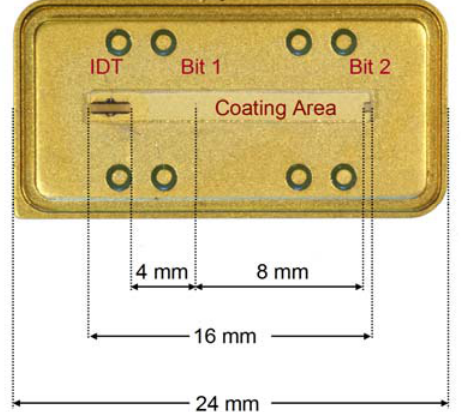
Figure 2. RFID-Tags used for chemical